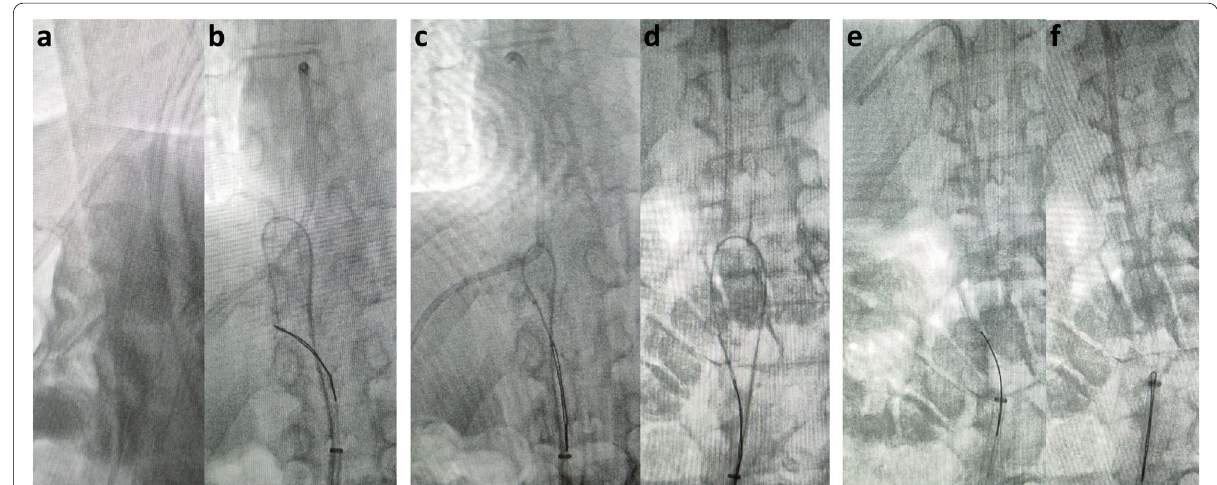
Fig. 2 Lateral fluoroscopy image demonstrating placement of the pigtail catheter around the catheter fragment ( a ). AP fluoroscopic image demonstrating the snaring of the hydrophilic glidewire ( b ), followed by pulling of the pigtail catheter and snare catheter ( c ), to free the cardiac end of the catheter fragment ( d ). This was then snared and removed ( e , f )